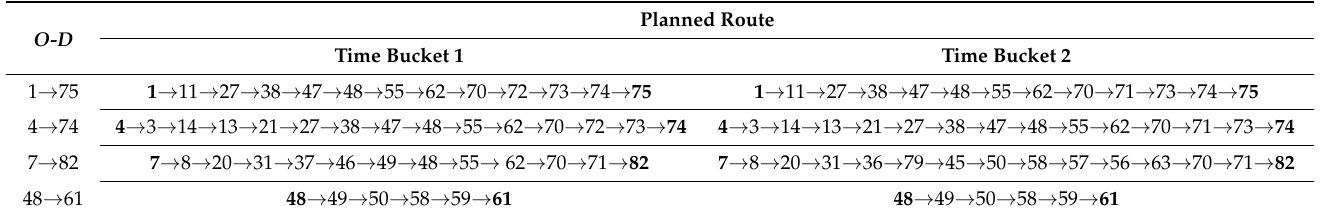
Table 9. Planned routes according to different traffic